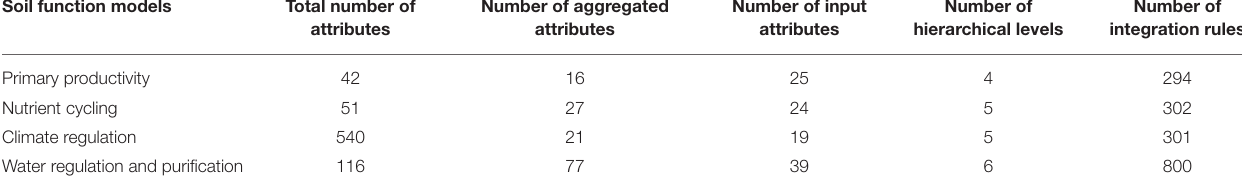
TABLE 1 | Structural properties of the DEX models of all five soil functions.